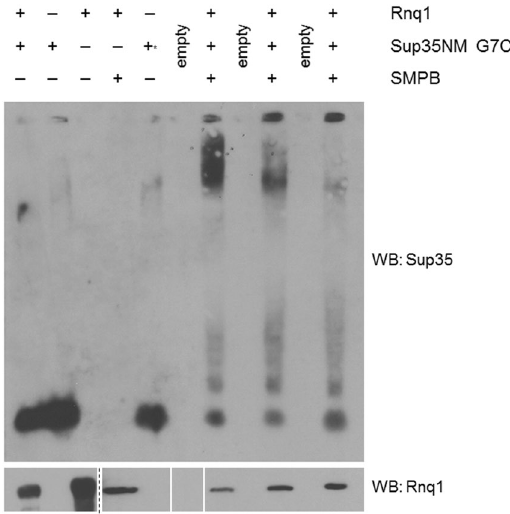
Figure 6. The N terminal region of Sup35 crosslinks to Rnq1. Site-directed crosslinking of Sup35-G7C to Rnq1 created high-molecular weight aggregates as visualized by SDD-AGE. Rnq1 alone, Sup35-G7C alone, and both proteins together without SMPB did not create large aggregates. The “ + * ” notation in the fifth lane indicates Sup35 monomer following treatment with TCEP. Western blot is a representative image from three independent experiments. In the lower blot, Rnq1 loading was confirmed by SDS-PAGE. Vertical white bars separate non-adjacent lanes of the same blot. The dashed line separates adjacent lanes of the same blot under differing film exposures for image clarity (full blots in Supplementary Figure S4). There is excess Rnq1 in lanes 1 and 3, samples prepared without crosslinker, to adjust for protein that is lost during sample desalting following attachment of the crosslinker (see Methods ). Three trials of crosslinking were included in each experiment and the crosslinking experiment was repeated with different batches of purified proteins three